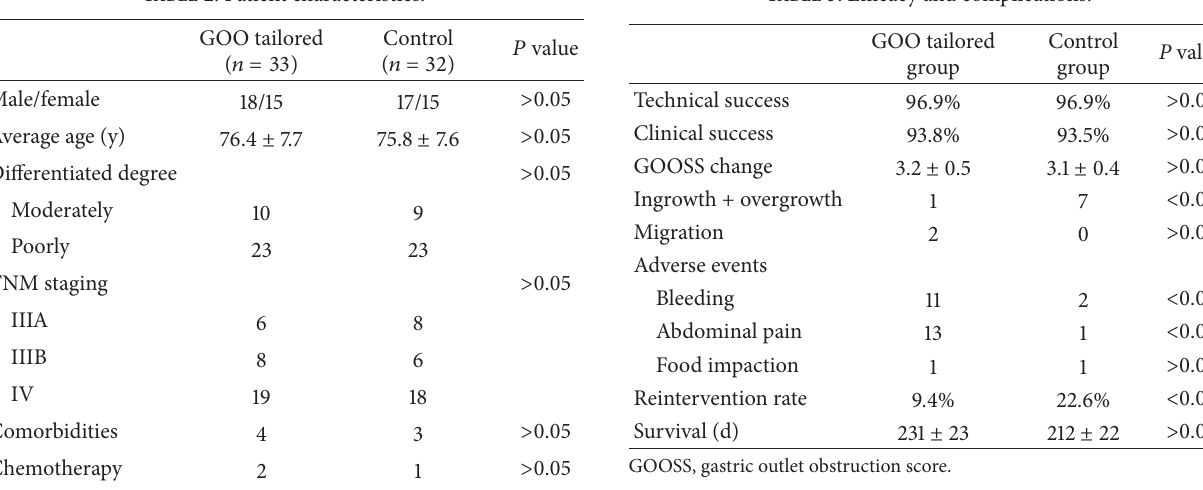
Table 2: Patient characteristics. Table 3: Efficacy and